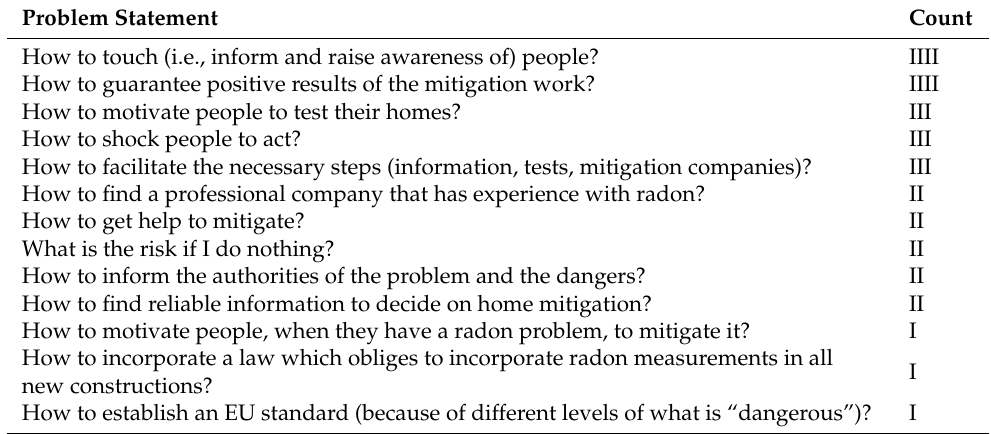
Table 1. Belgium: problem